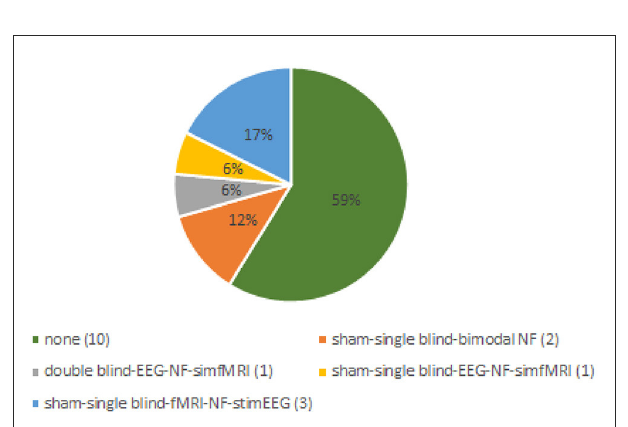
FIGURE4 Distribution of controls employed in the review’s studies. Sham neurofeedback is used to describe non-contingent feedback method. We consider controls absent if all participants of the studies received genuine feedback. With single blind we intend that participants of control groups were not aware of that. In the double-blind study both participants and experimenters were blind to NF group allocation. NF, neurofeedback; EEG, electroencephalograph; fMRI, functional magnetic resonance